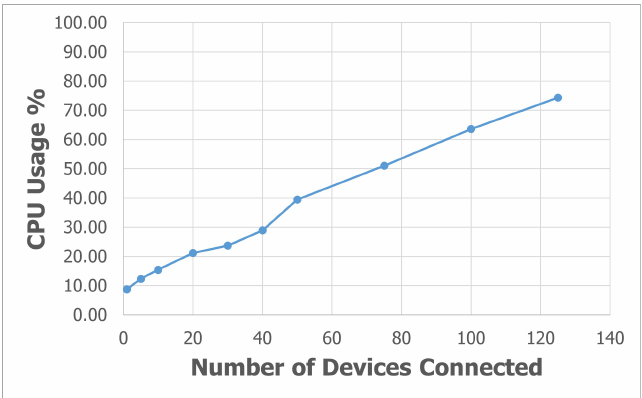
Figure 20. Average CPU usage rate with different numbers of